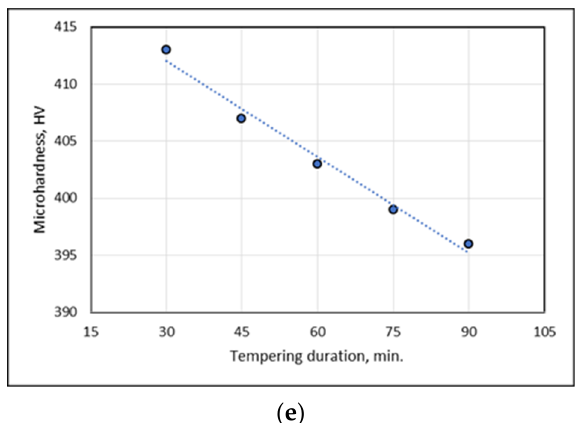
Figure 4. Dependences of mechanical properties of rolled products from 42CrMo4 grade steel on the duration of tempering at 500 °C: ( a ) tensile strength; ( b ) yield strength; ( c ) relative elongation; ( d ) reduction in area; and ( e ) microhardness HV.